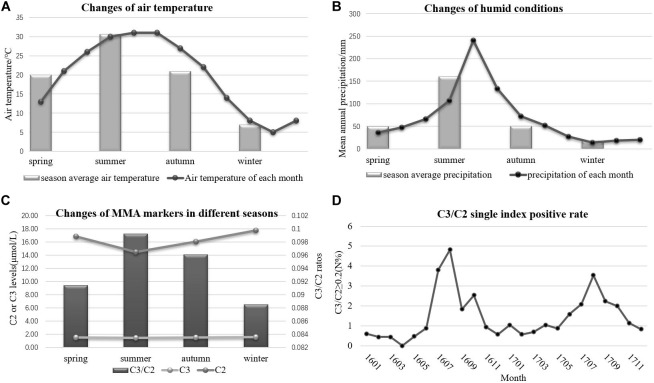
The variation of environmental conditions and MMA markers. (A) The changes of air temperature. (B) The changes of humidity. (C) The changes of MMA markers in different seasons. (D) The single index positive rate of MMA.